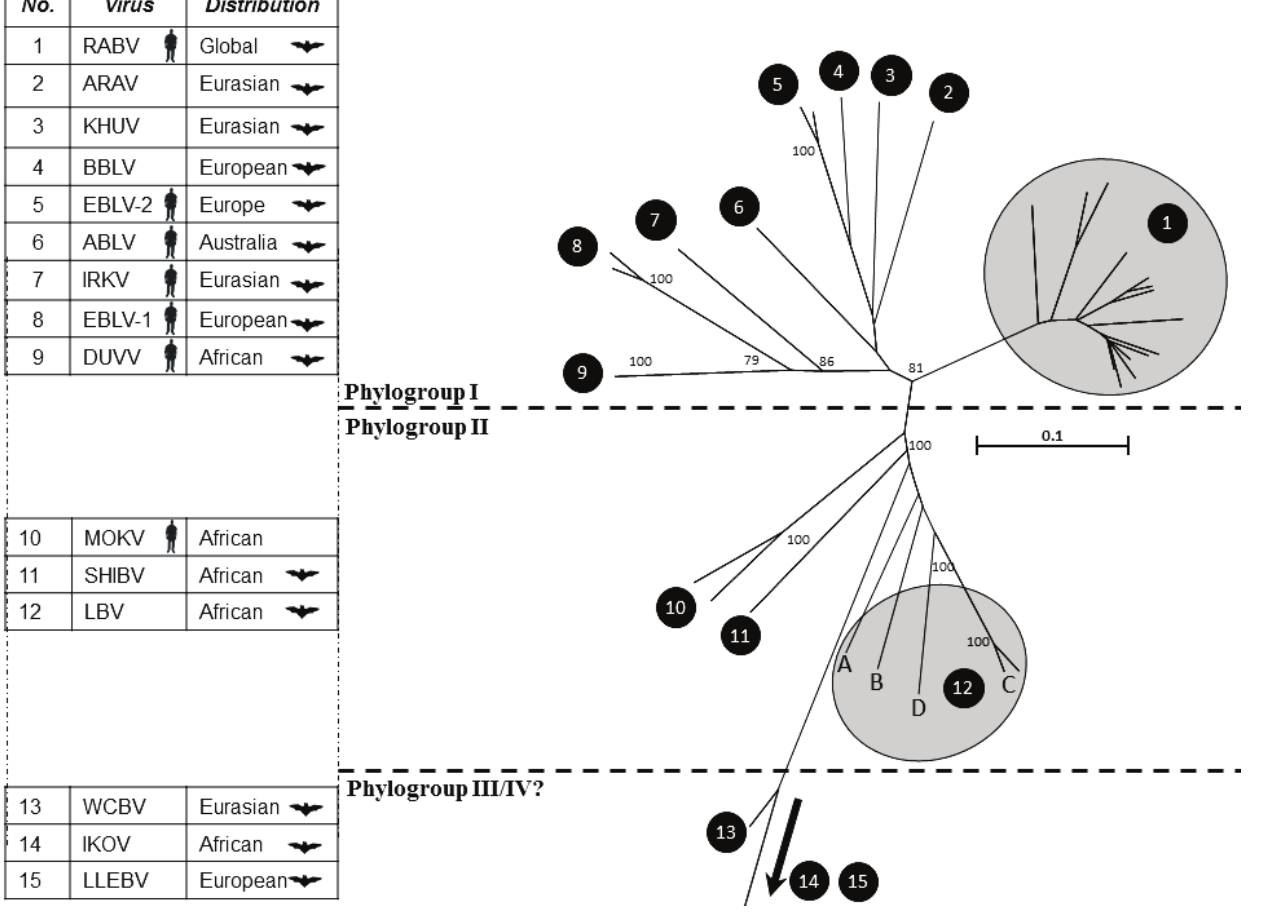
Figure 1. A phylogenetic analysis of the lyssaviruses. Numbers on the tree correspond to each of the lyssaviruses detailed in the accompanying table. Silhouetted species represent where viruses have been associated with bat infection and/or human fatalities. Virus acronyms are as defined in Table 1. The phylogenetic analysis is based on 405 nucleotides of the nucleoprotein gene. All sequences were aligned using ClustalW. Bootstrap values at significant nodes are